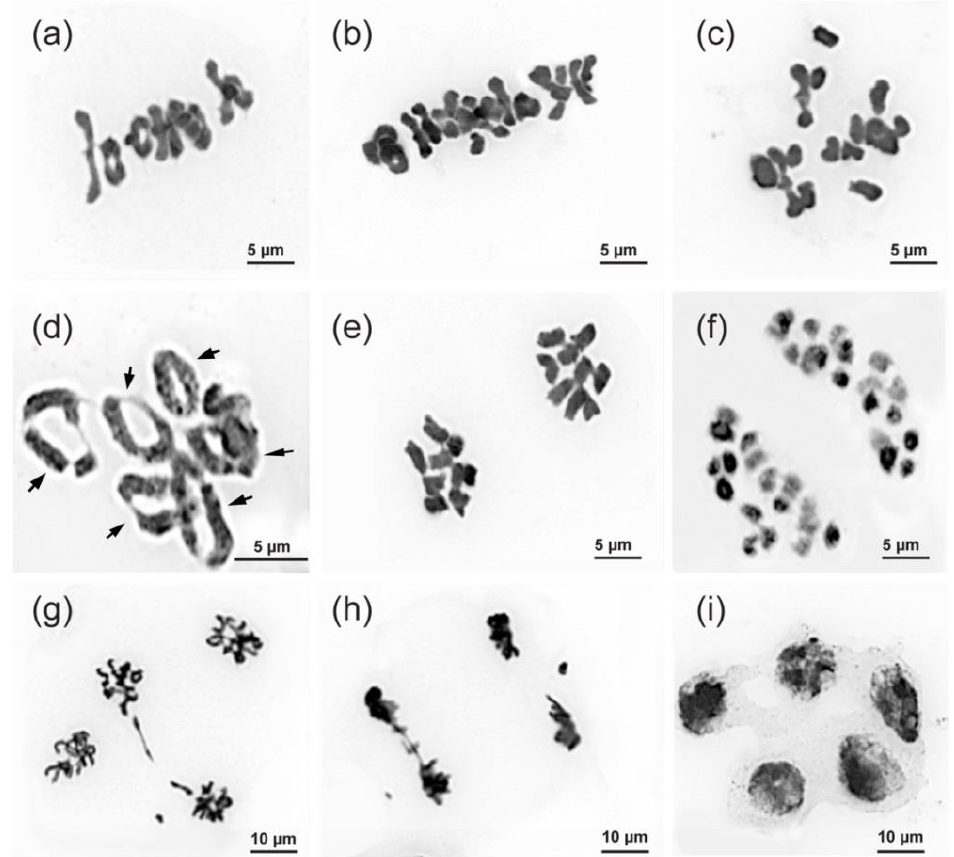
Figure 5. Chromosome behavior during meiosis in maternal pollen cells of Polemonium caeruleum. ( а ) M-I, a diploid cell (9 II ); ( b ) M-I, a tetraploid cell (18 II ); ( c ) M-I, chromosome lagging in a diploid cell; ( d ) M-I, quadrivalents are indicated with arrows; ( e ) A-I, (9:9); ( f ) A-I, (18:18); ( g ) A-II, perpen- dicular spindle orientation in a tetraploid cell; ( h ) A-II, chromosome elimination in a tetraploid cell; ( i ) pentads. Scale bars are specified under the images.